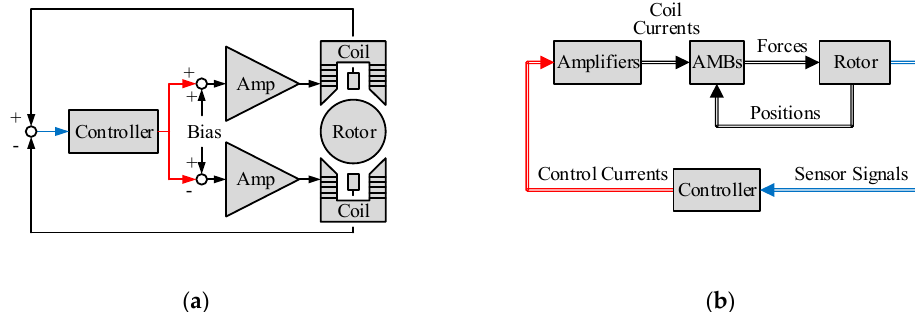
Figure 1. Typical AMB control scheme: ( a ) one control axis biasing; and ( b ) MIMO Control block diagram.